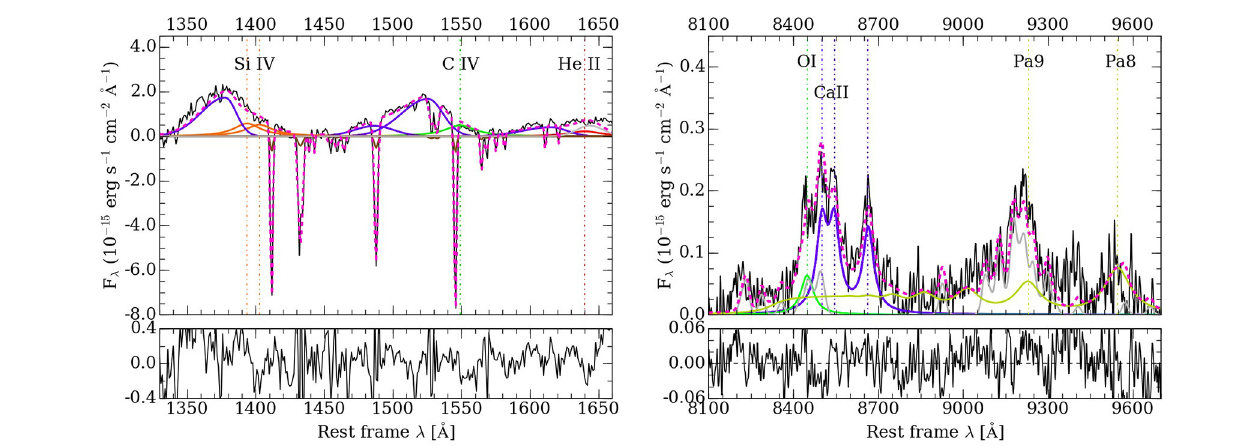
FIGURE 2 | Multicomponent analysis on the UV, optical and NIR spectra of HE0359-3959 after continuum subtraction. (Top panels) : In the left side is shown the UV spectrum, while in the right one is shown the near–infrared spectrum. The different components [broad (BC), BLUE, and narrow (NC)] in the line fitting are specified in each panel. Vertical lines indicate the rest-frame obtained through H β NC . The gray line marks the Fe II contribution. The vertical scale represents the relative flux in units of 10 − 15 erg s − 1 cm − 2 Å − 1 . (Bottom panel) : Residuals of the fittings. The horizontal scale is the radial velocity shift in km s − 1 . In all the panels the horizontal scale represents the rest–frame wavelength in